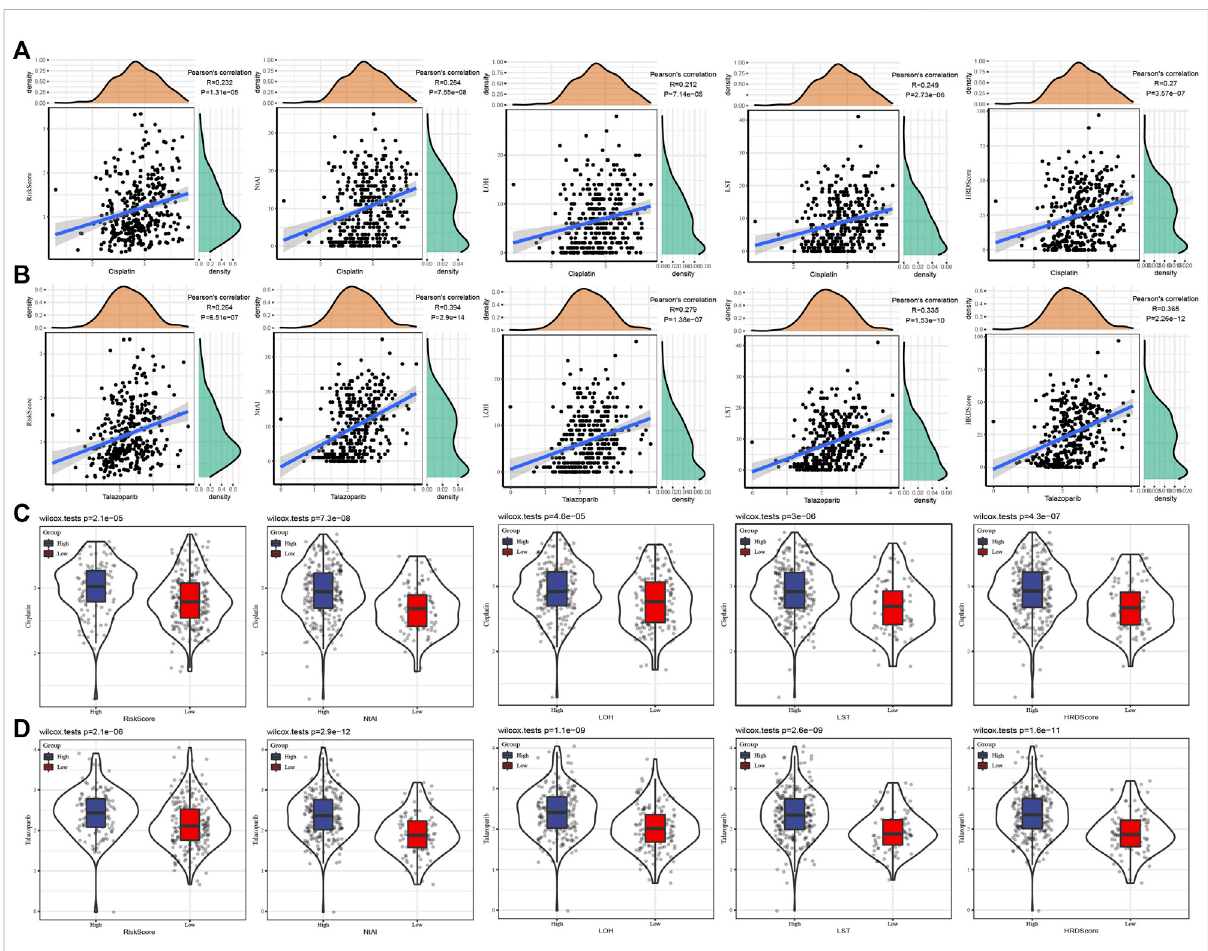
FIGURE 4 Association between risk score/HRD score and drug sensitivity of GC therapy. (A) The correlation between Cisplatin and risk score, HRD score, and HRD component scores was analyzed. (B) Pearson correlation analysis between Talazoparib and risk score, NtAI score, HRD-LOH score, LST score, and HRD score respectively. (C) Sensitivity to Cisplatin in GC cases grouped according to risk score, NtAI score, HRD-LOH score, LST score, andHRDscore. (D) TheIC50valuesofTalazoparibinGCdiseasecasesweredividedintoriskscore,NtAIscore,HRD-LOH score,LSTscore,and HRD score groups